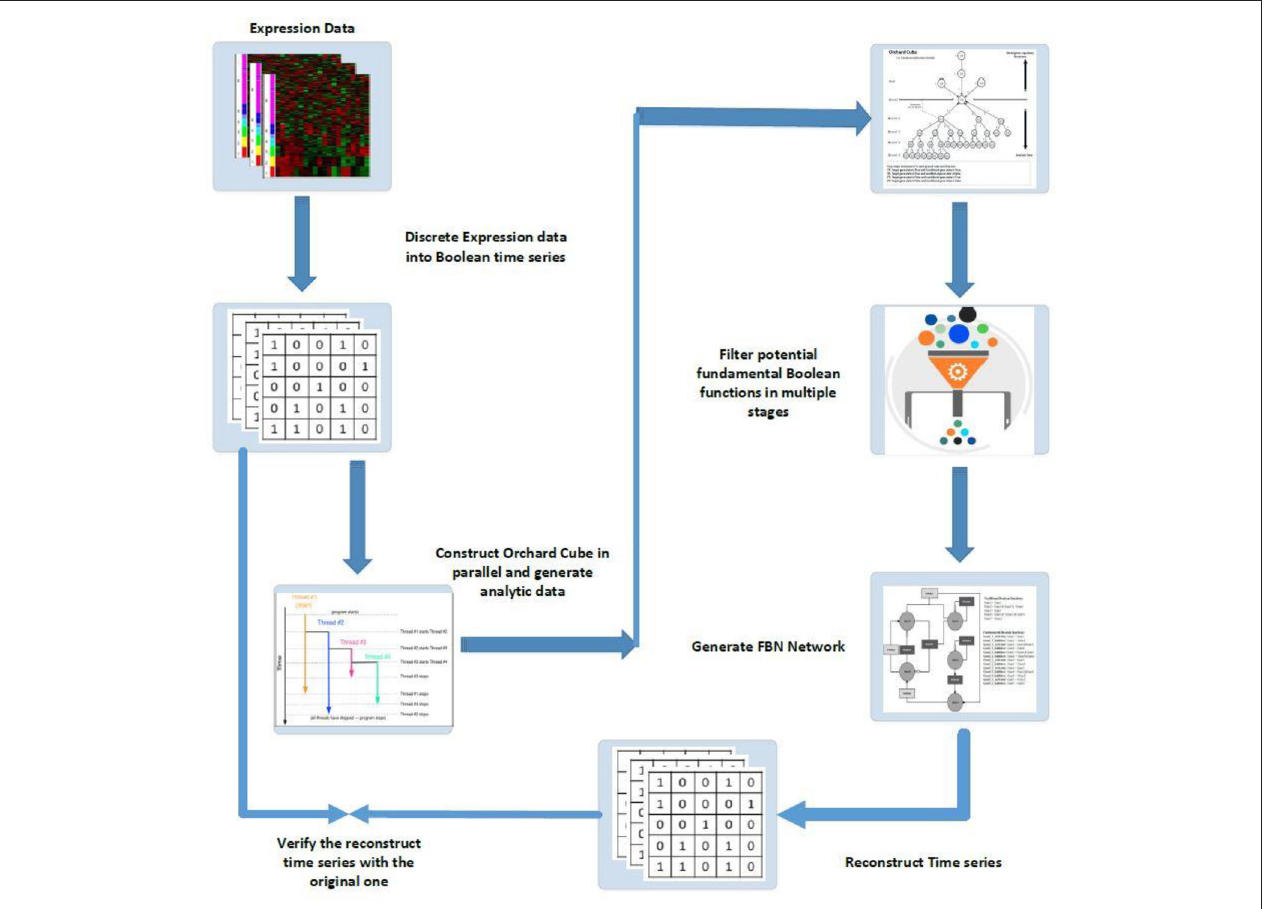
FIGURE 6 | Schematic diagram of FBN modeling and network inferences: (1) discrete expression data into Boolean time series; (2) construct orchard cubes in parallel to generate analytical data and store all precomputed measures; (3) mine potential regulatory rules for all target genes through the constructed orchard cube based on some criteria; (4) generate the fundamental Boolean network; (5) use the generated network to reconstruct the input time series by giving the initial states of all original inputs and; (6) verify the reconstruction time series with the original series, if necessary, to gain confidence in the results.